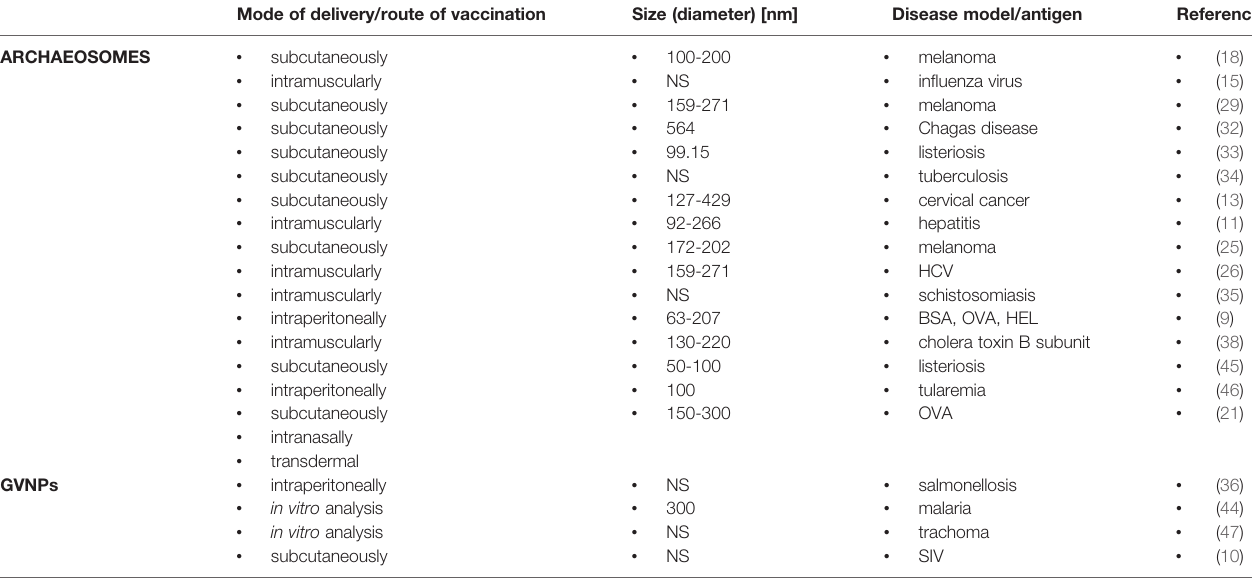
TABLE 3 | Particle size and the mode of delivery of the archaeosomes and gas vesicles in different disease models. Mode of delivery/route of vaccination Size (diameter)